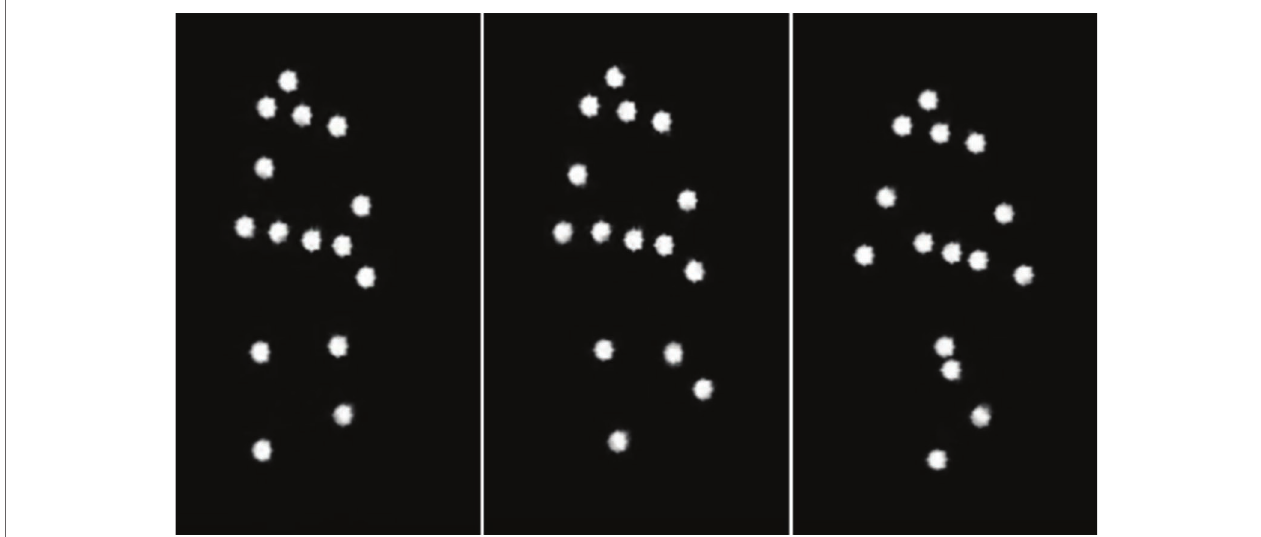
FIGURE 1 | Illustration of point-light biological motion. Three consequent static frames exemplifying human walking as a set of dots placed on the main joints and head of an invisible actor body. A walker is seen facing left in intermediate position between the frontal and sagittal